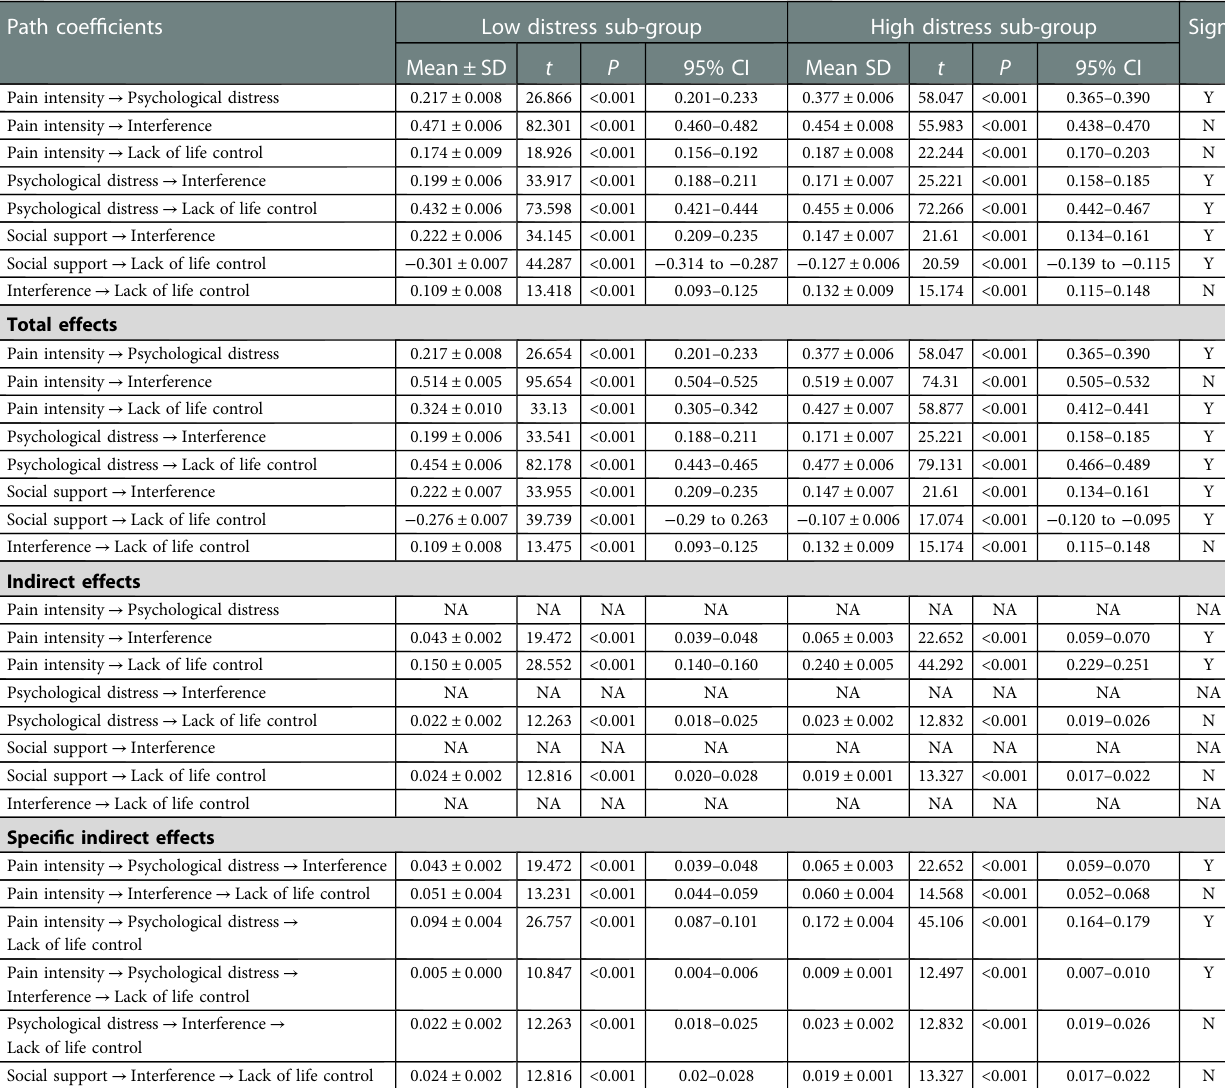
TABLE 6 Path coef fi cients, total effects, indirect, and speci fi c indirect effects for the Low distress ( N =20,986) and high distress ( N =19,288) subgroups. Mean±SD, t -values, P -values, and 95% con fi dence intervals (95% CI) are reported. Path coef fi